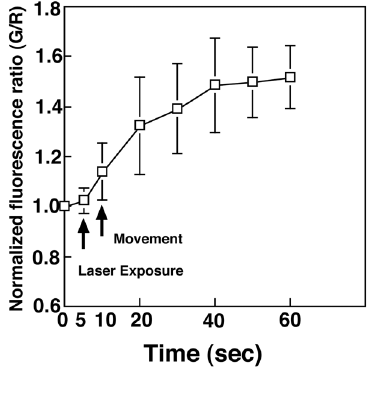
Fig. 5 Changes of intracellular Ca 2+ concentration in stimulated ECs as indicated with normalized fluorescence ratio of Fluo-4 and Fura-red. ECs were stimulated in the absence of extracellular Ca 2+ with